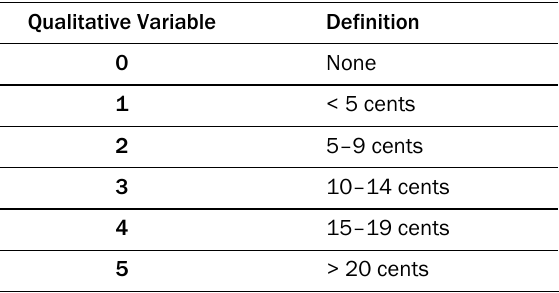
Table 3. Willingness To Pay Summary